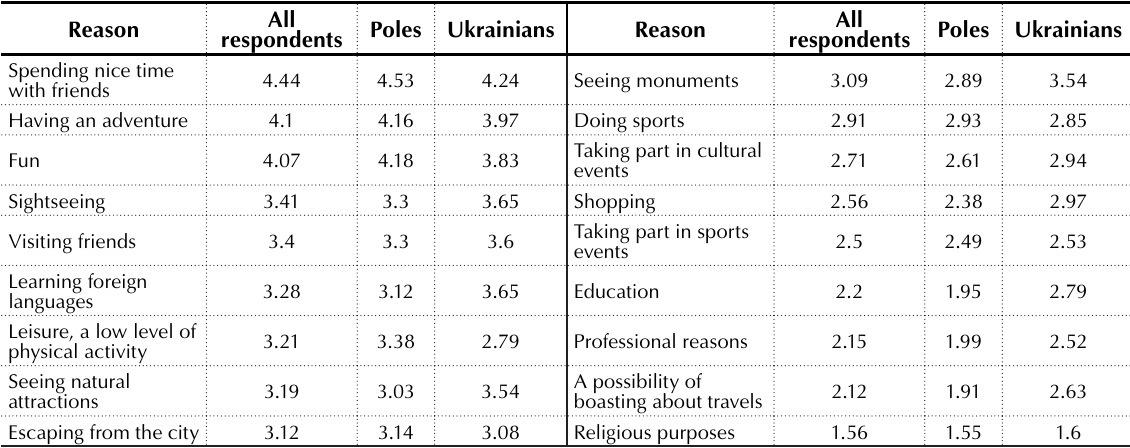
Source: Own work based on the survey conducted.